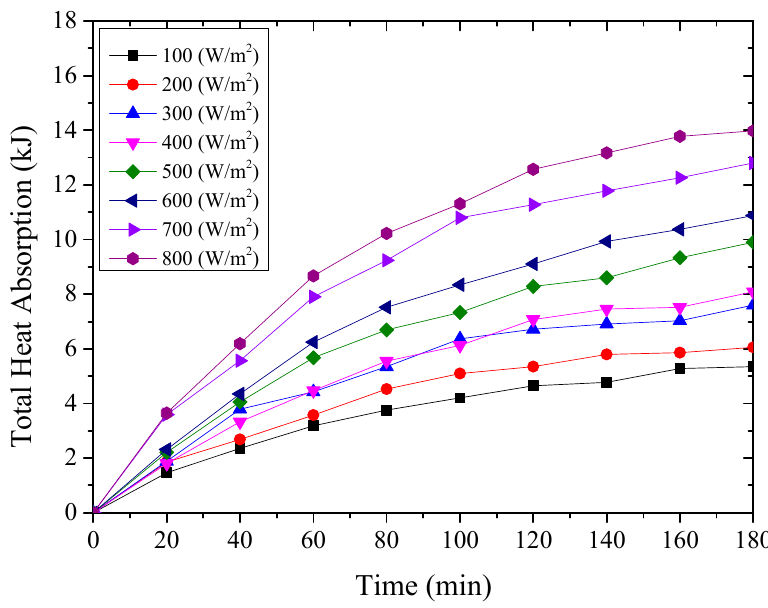
Figure 13. The amount of heat absorbed by the nanoporous alumina sheet with 400 nm pore